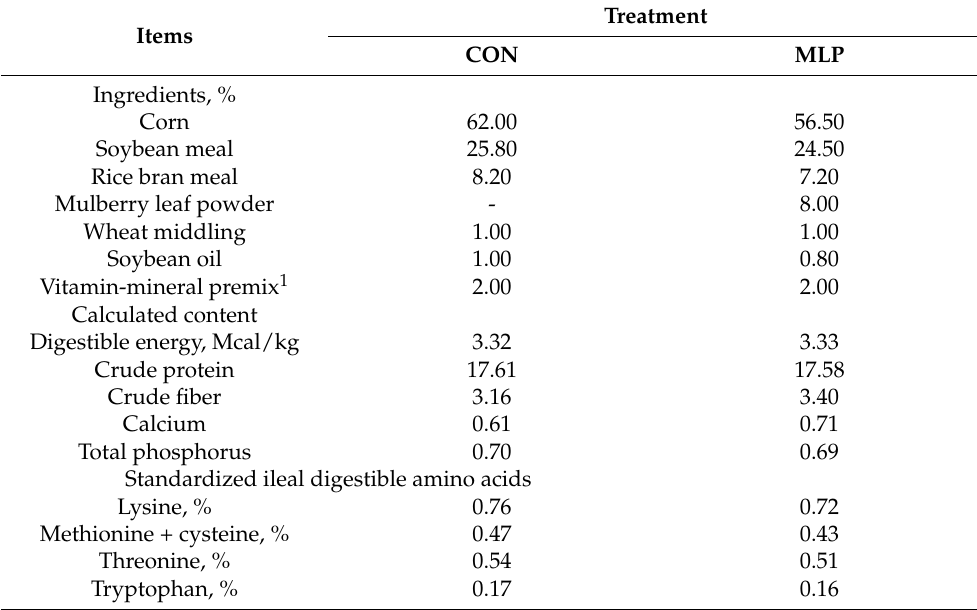
Table 2. Feed ingredients and nutrient composition of the experimental diet (as-fed